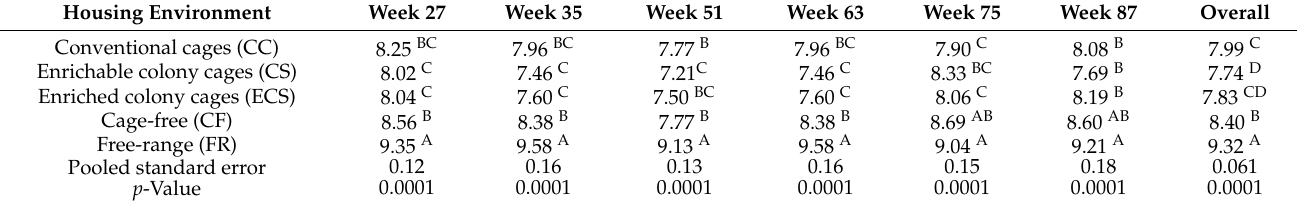
Table 7. The effect of housing environment on yolk color (Rouche) of brown egg layers by week and